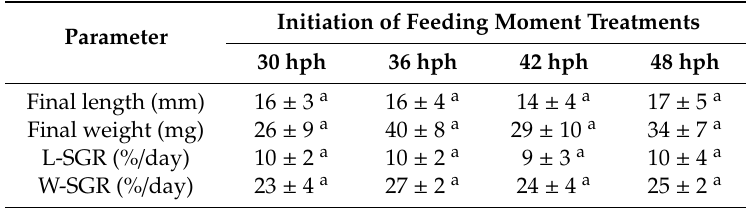
di ff erent initial feeding times.